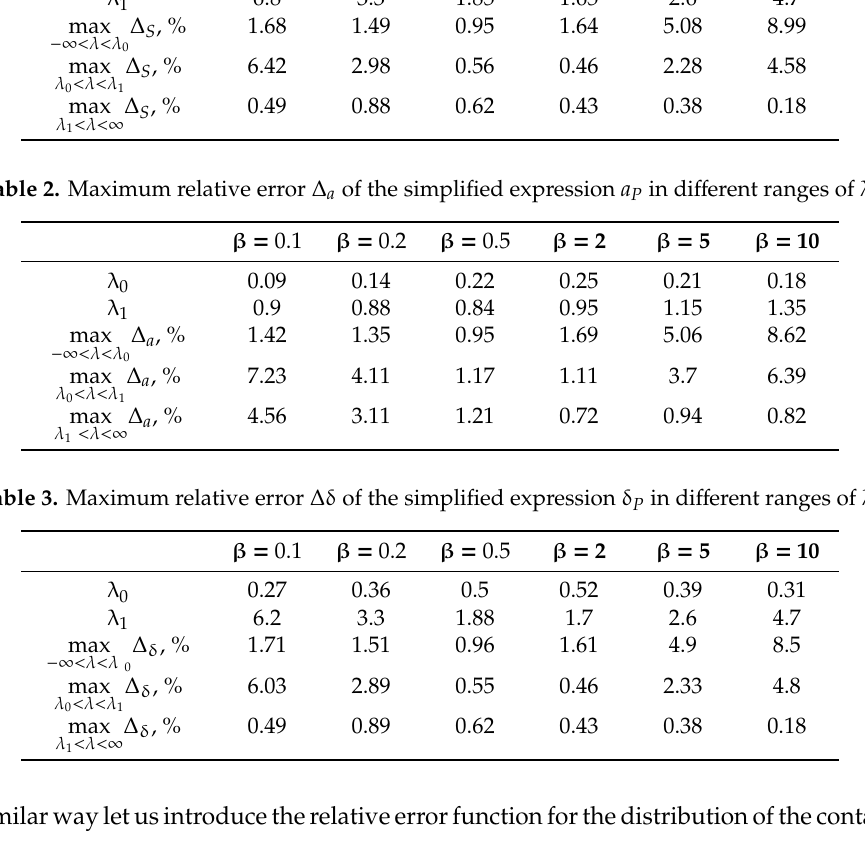
Table 1. Maximum relative error ∆ S of the simplified expression S P in di ff erent ranges of λ . β = 0.1 β = 0.2 β = 0.5 β = 2